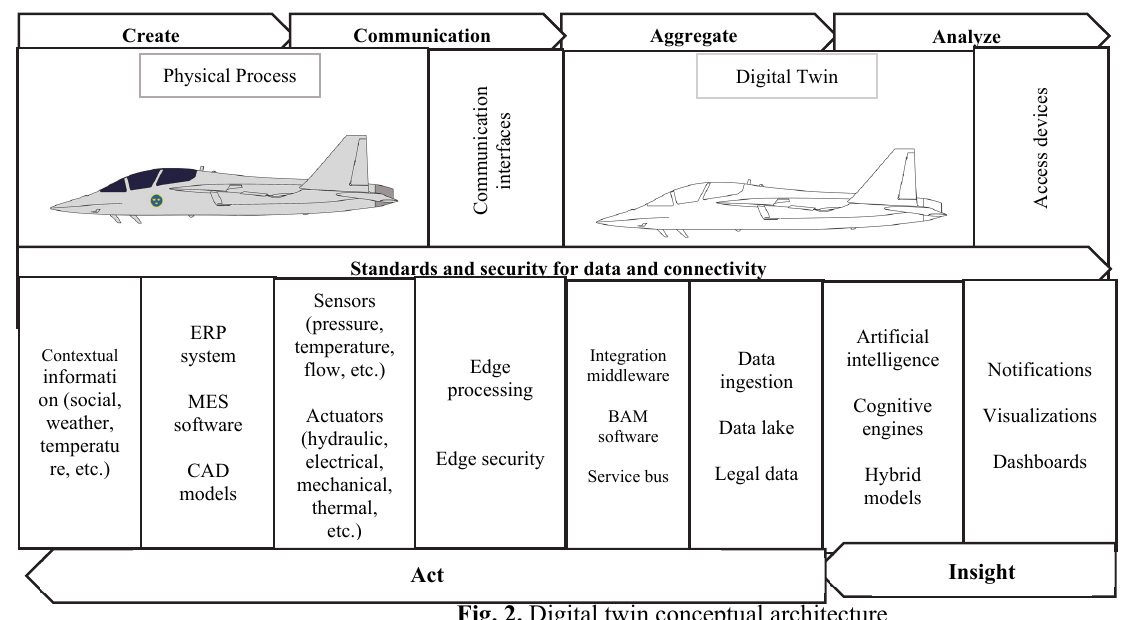
Source: Deloitte University